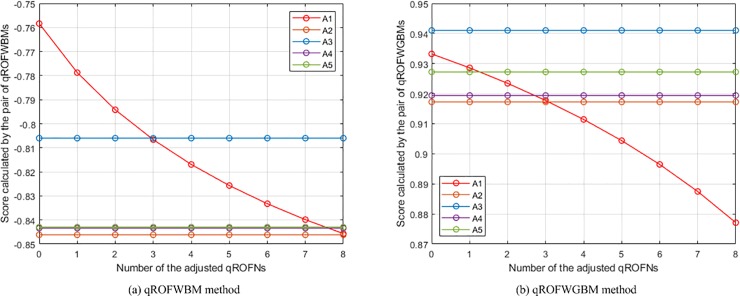
The changes of the places of A1 in the rankings of the WBM and WGBM methods.